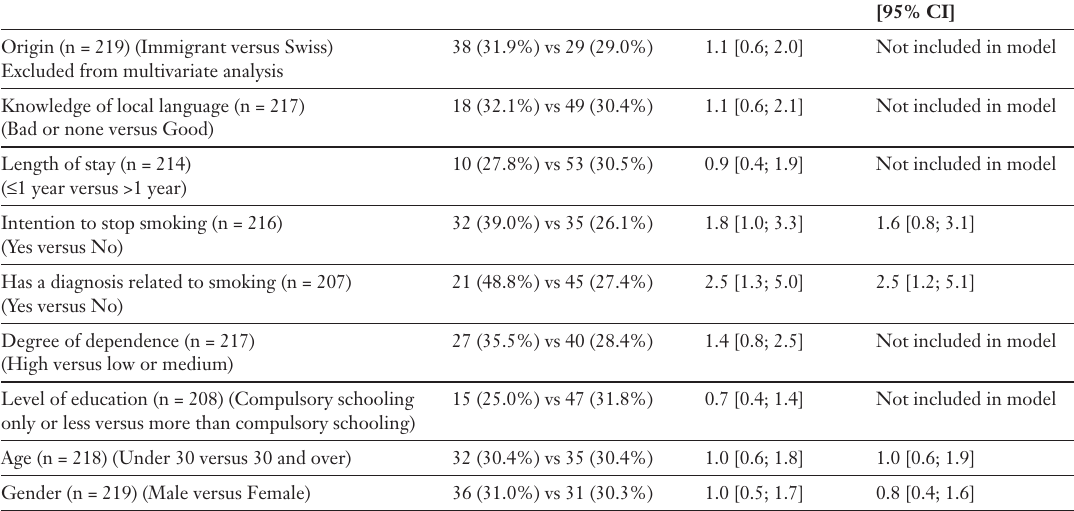
Odds ratios of coun- seling versus no counseling on smoking